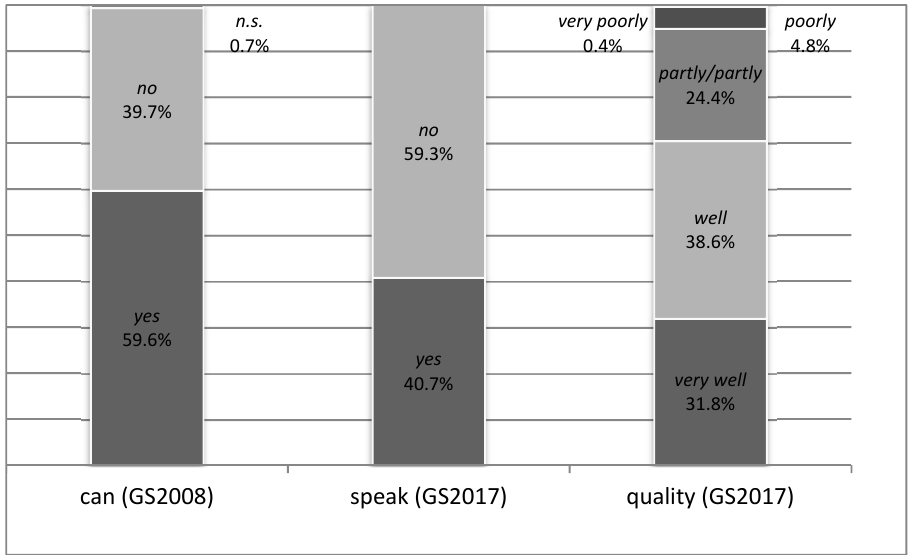
Figure 10. Results of the items on dialect (GS2008, GS2017).